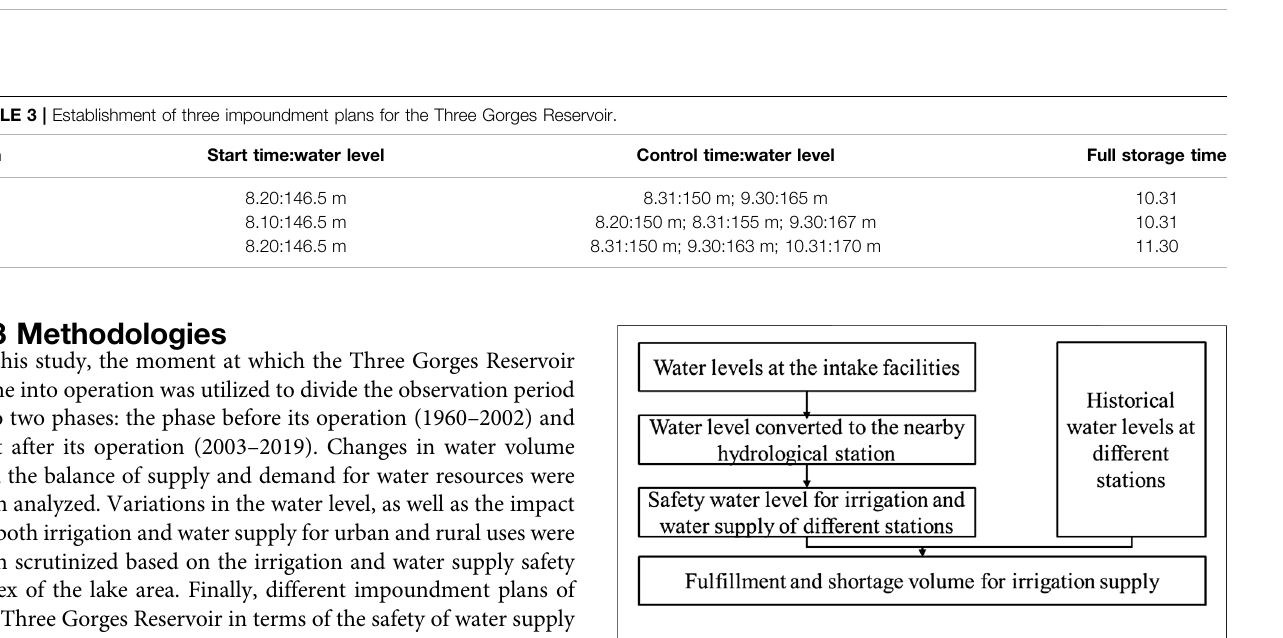
FIGURE 2 | Analysis fl ow on the ful fi llment of irrigation and water supply.